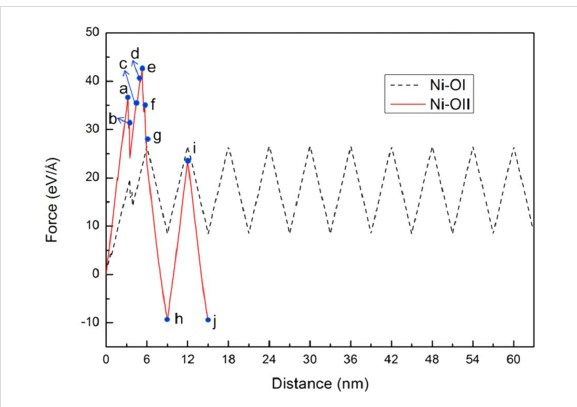
Figure 17: Force–distance curve of Ni along orientation I (black dashed line) and orientation II (red line) under ten times of cyclic loading, where the first shear distance of the sample was 6 nm, and the reverse shear and shear distance were 3nm. The letters a–j repre- sent the observation positions in Figure